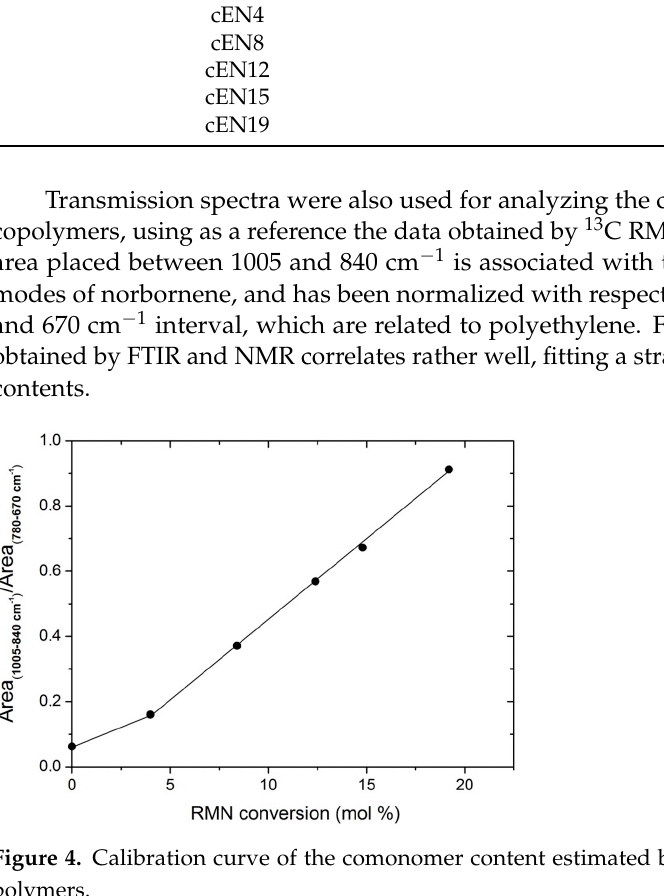
Table 6. Carbonyl index for all the samples.